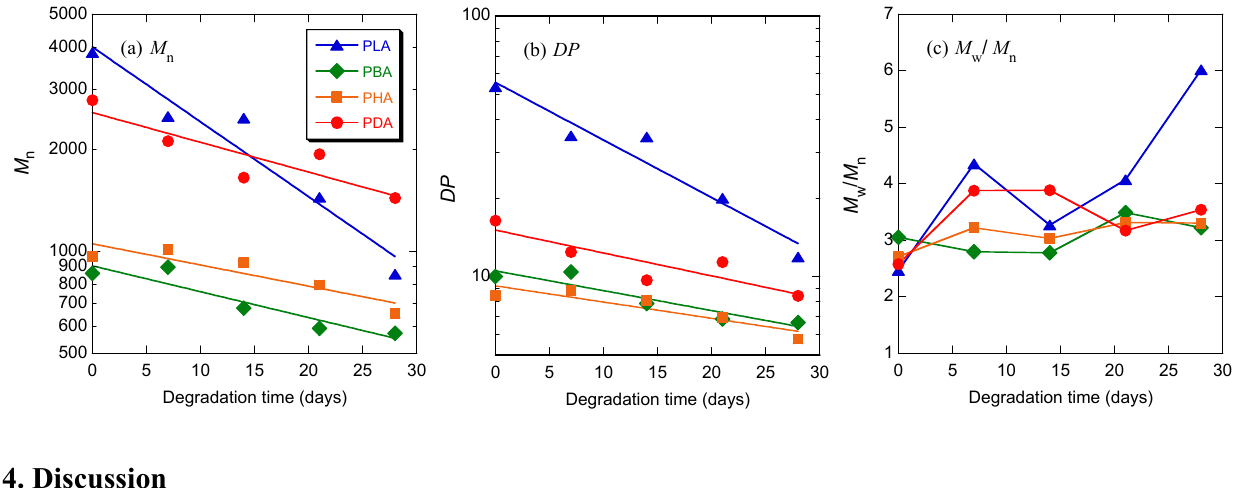
Figure 9. M ( a ), DP estimated from M n ( c ) of PLA, PBA, PHA, and PDA during hydrolytic degradation at 37 °C, as a function of degradation